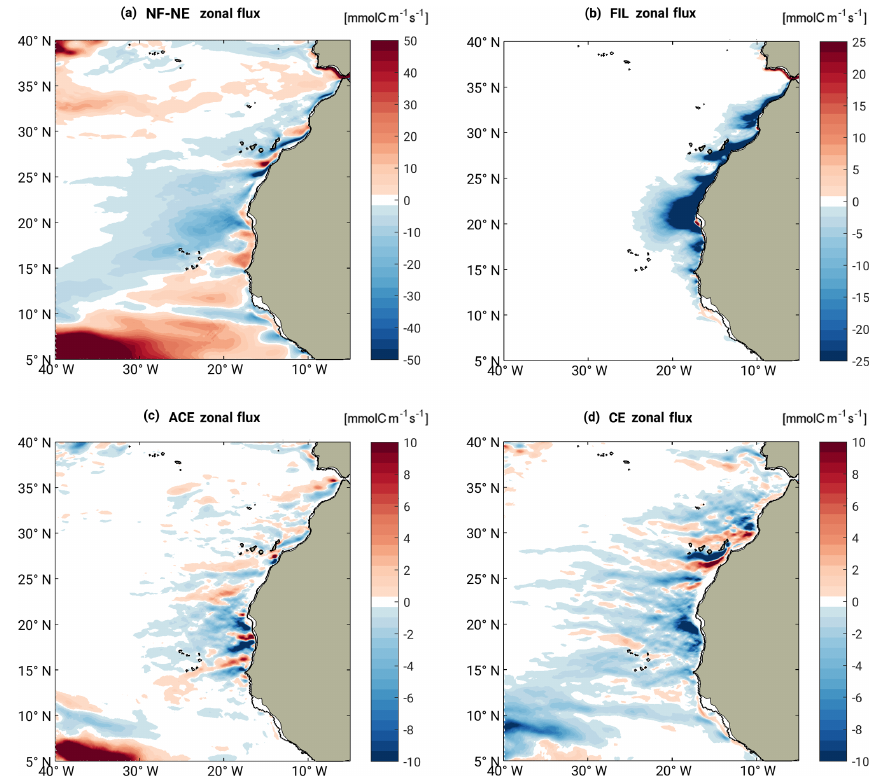
Figure 11. Decomposition of the zonal advective transport of C org into (a) non-filament–non-eddy NF-NE, (b) filament FIL, (c) anticyclonic ACE and (d) cyclonic CE flux. Fluxes are integrated within the top